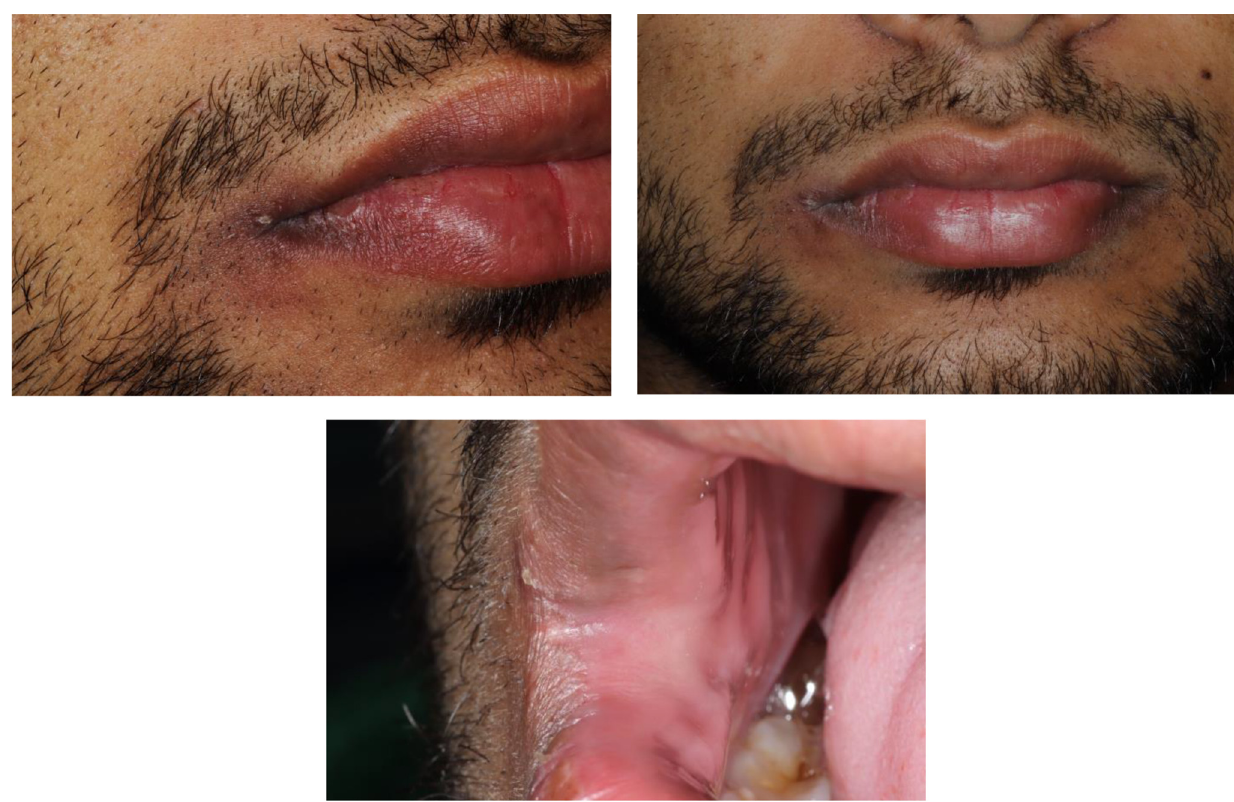
Figs. 4 – 6. Extraoral photograph showing the complete healing by 14